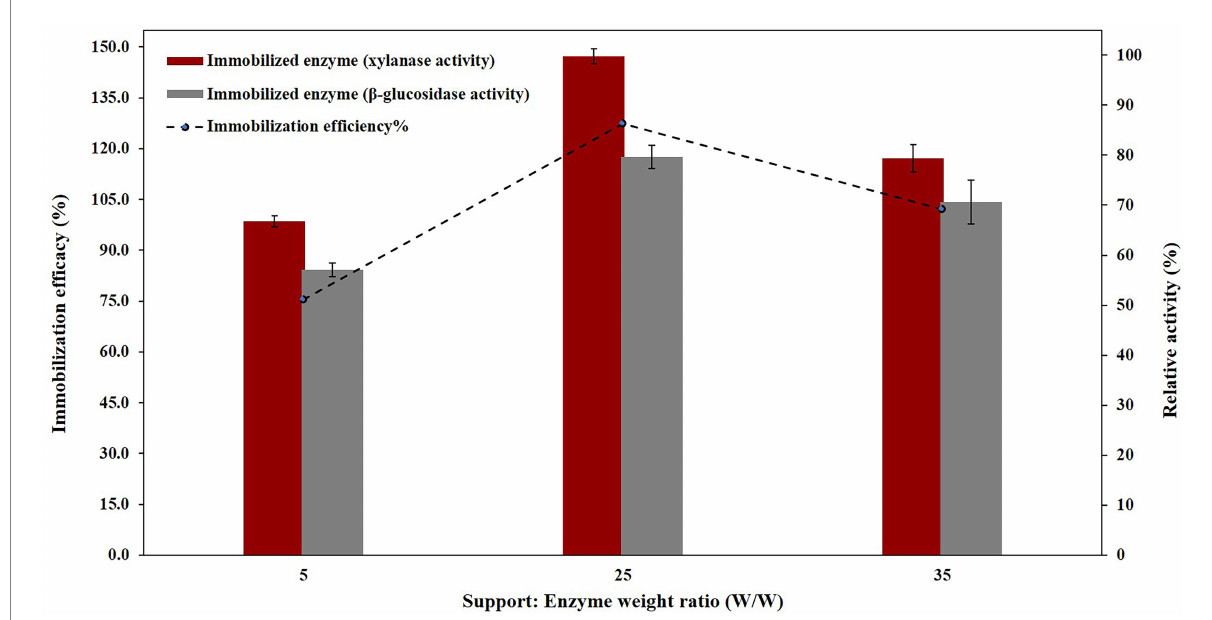
FIGURE 3 PersiBGLXyn1 relative activity (%) after immobilization on NC nano-carrier at various support:Enzyme weight